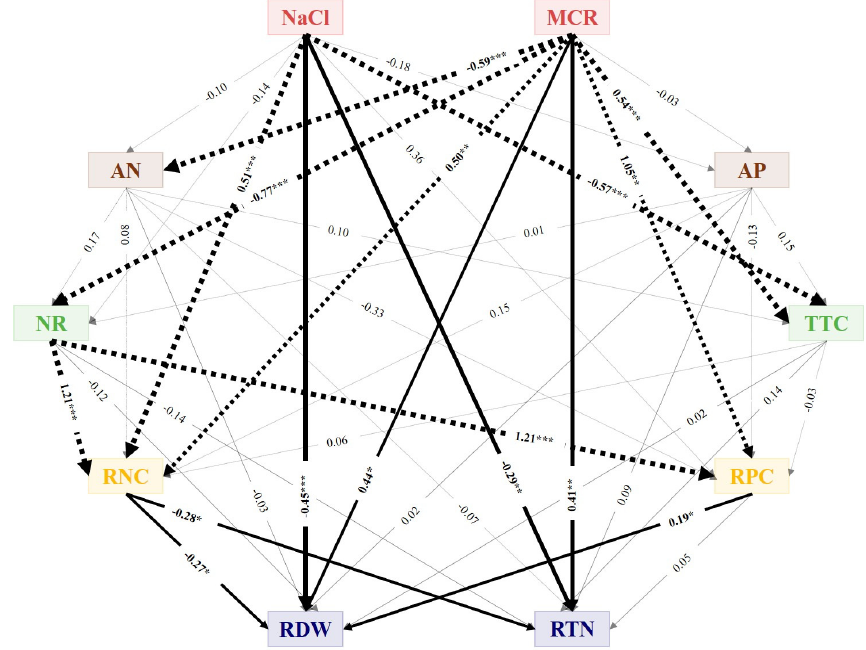
Figure 7. Structural equation model of effects of NaCl level and mycorrhizal colonization rate on root dry weight and tip number. Numbers on lines are standardized path coefficients. Widths of lines indicate strength of causal influence. Solid lines represent direct effects on root dry weight and tip number; dotted lines represent effects on soil nutrient contents, root physiologies, and nutrient contents. Abbreviations: NaCl, NaCl level; MCR, mycorrhizal colonization rate; AN, soil alkali − hydrolyzable nitrogen; AP, soil available phosphorus; NR, nitrate reductase activity; TTC, root activity; RNC, root nitrogen content; RPC, root phosphorus content; RDW, root dry weight; RTN, root tip number. *, p < 0.05; **, p < 0.01; ***, p < 0.001.